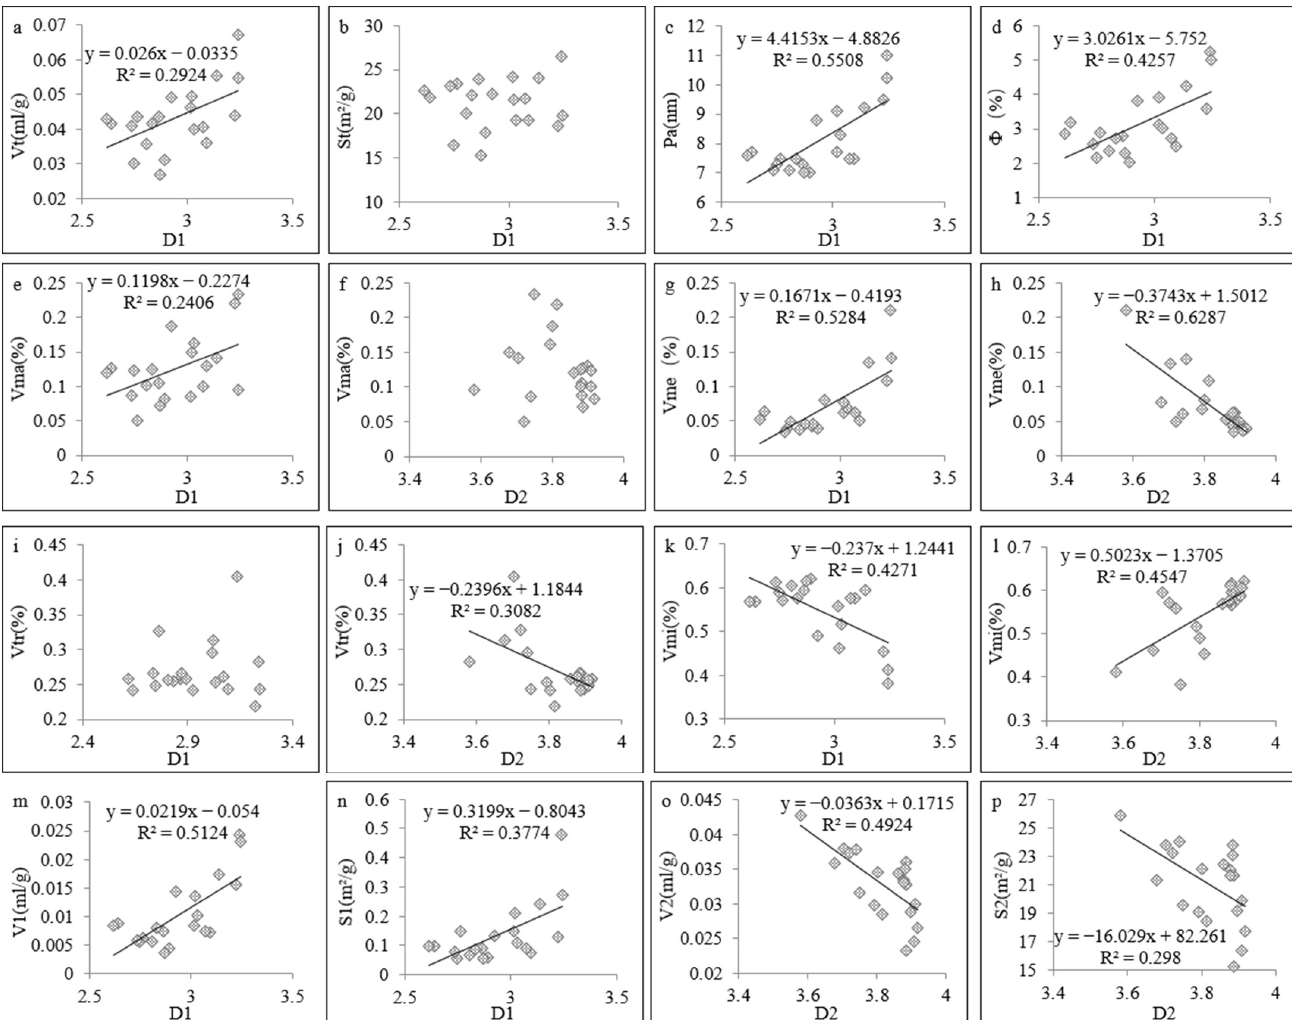
Figure 10. Correlations between fractal dimensions and pore parameters. ((a-p), samples M1-M20).